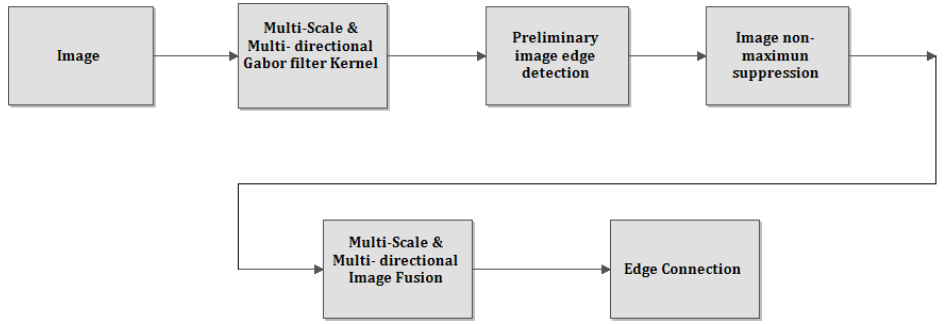
Figure 3. Gabor filter-based edge detection